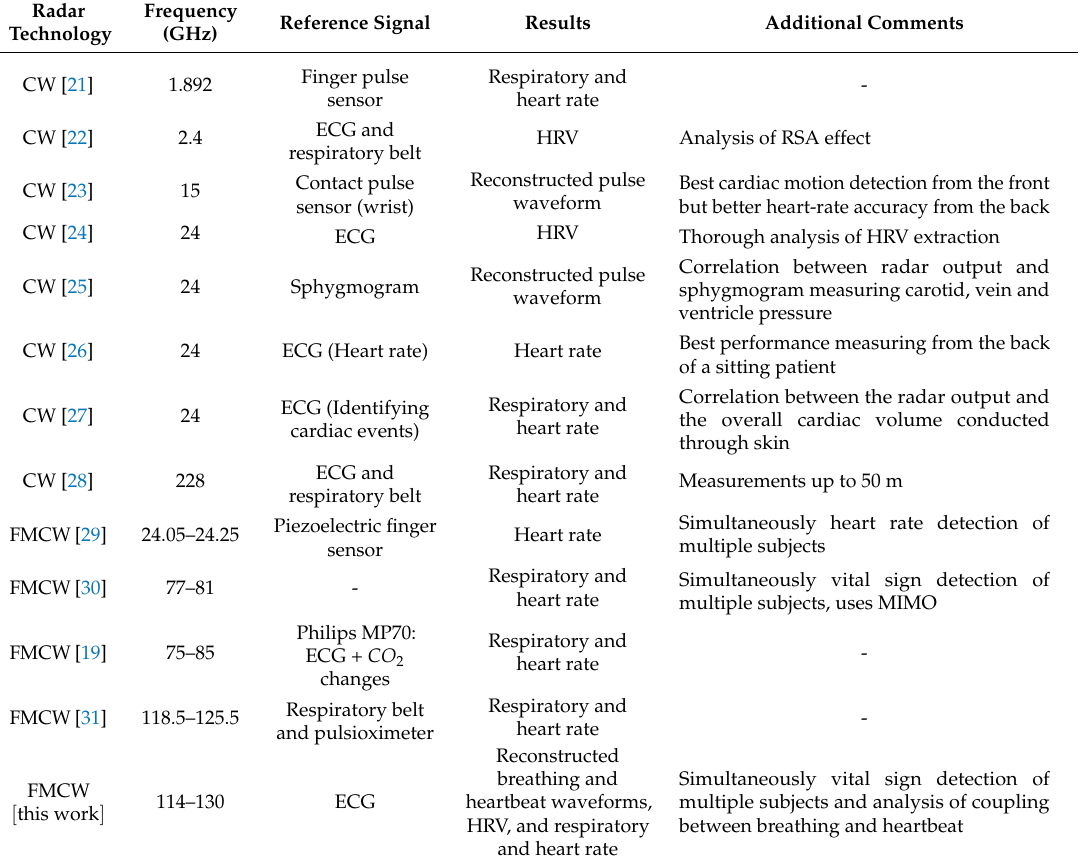
Table 2. Vital sign monitoring with radar